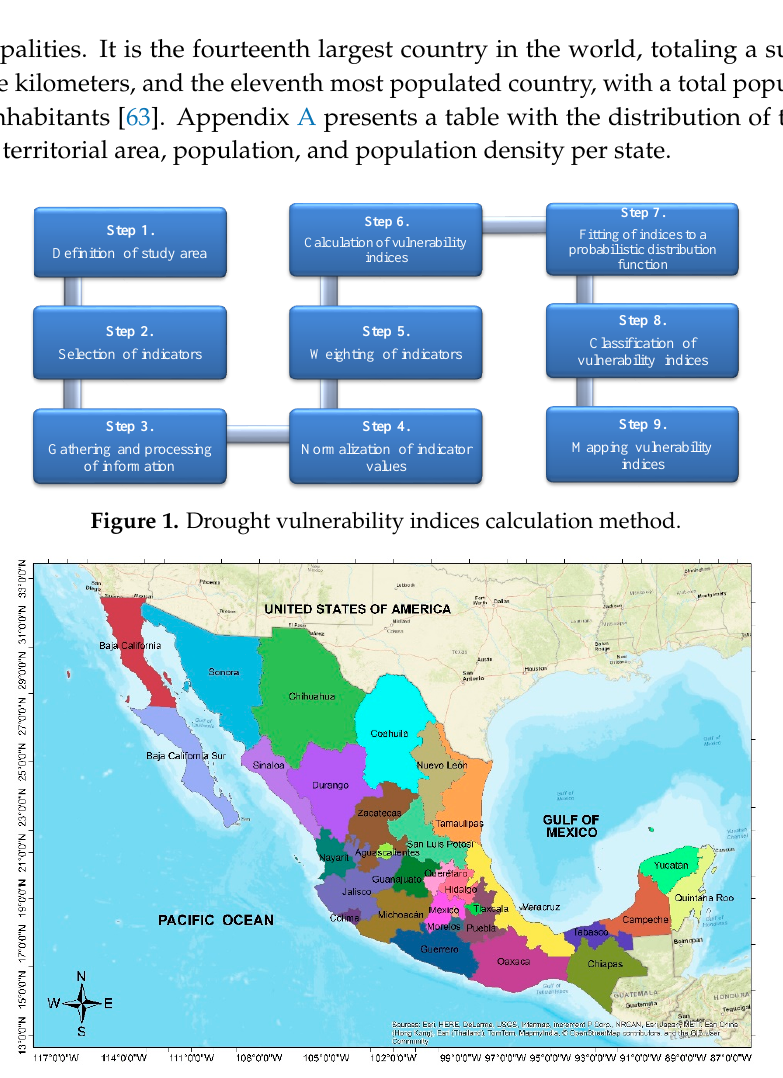
Figure 2. Geographical location and political distribution in the Mexican Republic.